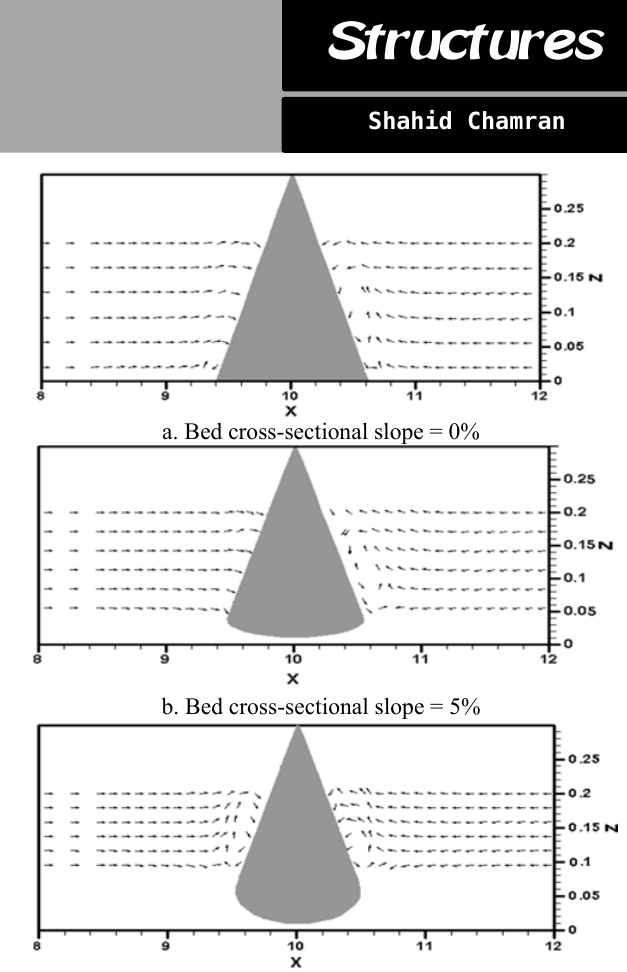
Fig.16 Velocity fields in the vertical plane at y= 0.25m for the groyne with structural slope = 1:2 at various cross- sectional bed